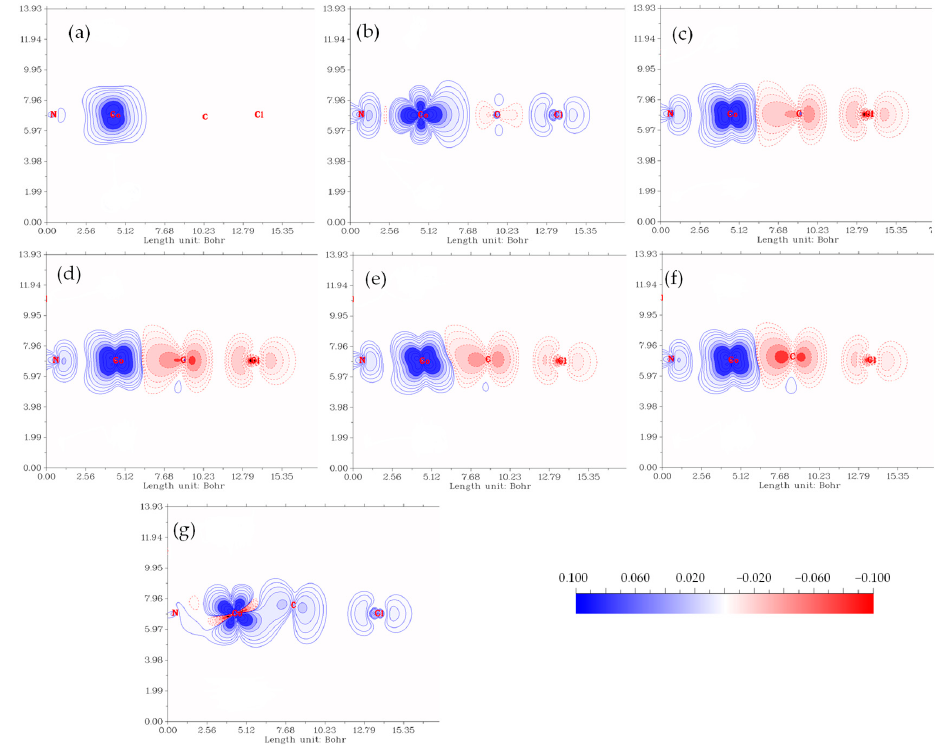
Figure 5. Electron spin-density contours maps of the reaction mediated by the Co II Cbx at the IRC points ( a ) ξ R , ( b ) ξ SR , ( c ) ξ TS , ( d ) ξ SP , ( e ) ξ SP , ( f ) ξ SP , and ( g ) ξ P . All the maps are parallel to the Co–C interaction, and perpendicular to the basal plane of the Co II Cbx complex. The color scale is general for all the graphs.